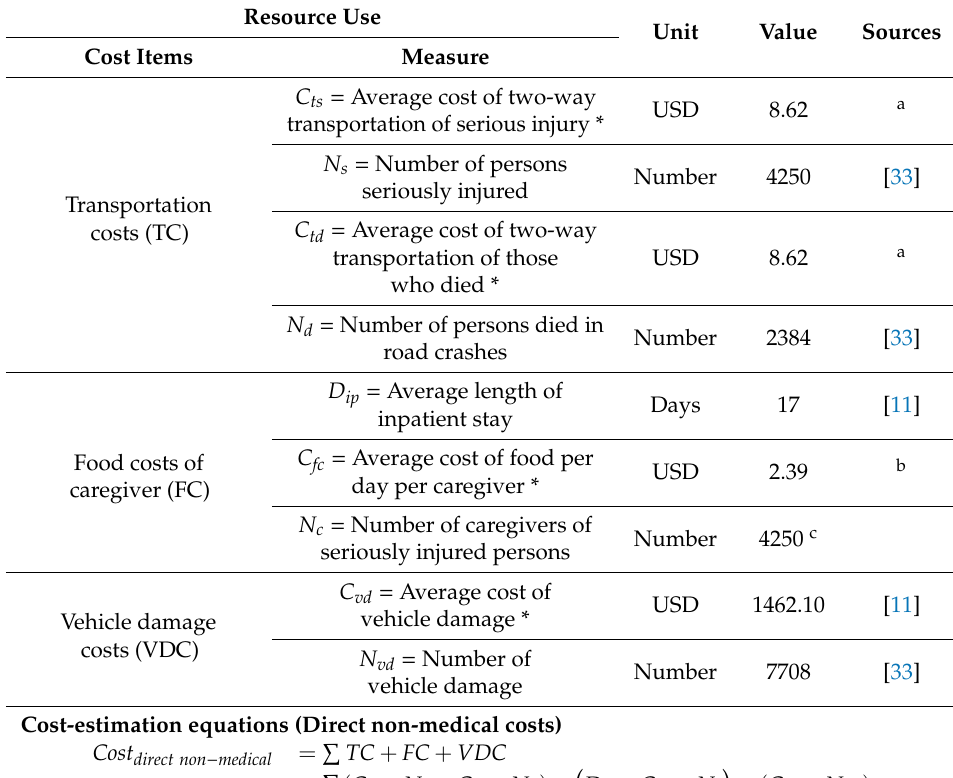
Table 2. Base case values and equations for cost calculation (direct non-medical